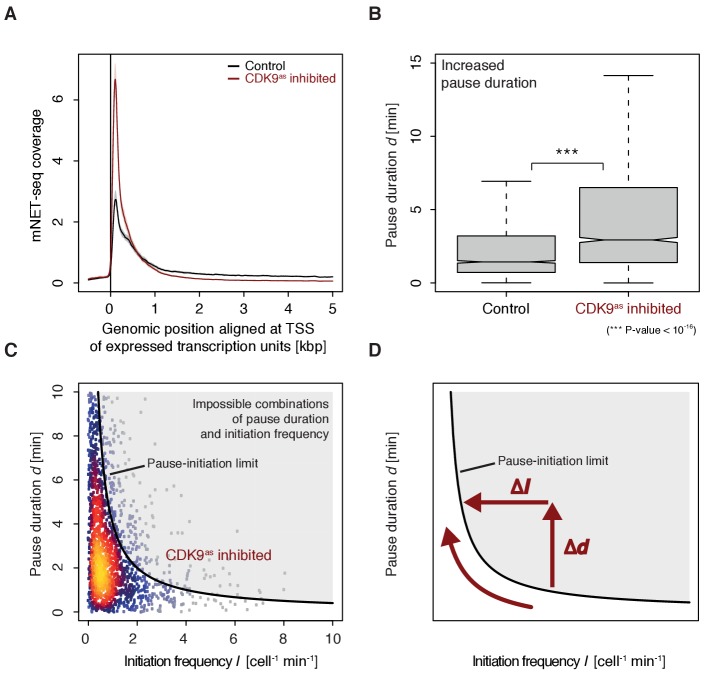
CDK9 inhibition leads to increased pause duration.(A) Metagene analysis comparing the average mNET-seq signal before and after CDK9 inhibition. Two biological replicates were averaged. The mNET-seq coverage was averaged for 2538 investigated TUs (Materials and methods). TUs were aligned with their TSS. Shaded areas around the average signal (solid lines) indicate confidentiality intervals (Materials and methods). (B) Distributions of gene-wise pause duration d [min] before (control) and after CDK9 inhibition. (C) Scatter plot between the initiation frequency I [cell−1min−1] and the pause duration d [min] after CDK9 inhibition for 2135 common TUs with color-coded density estimation. The grey shaded area depicts impossible combinations of I and d (Ehrensberger et al., 2013) assuming that steric hindrance occurs below a distance of 50 [bp] between the active sites of the initiating Pol II and the paused Pol II. (D) Schematic of changes in pause duration (Δd) and initiation frequency (ΔI) upon CDK9 inhibition. As a consequence, data points in panel (D) are moved to the left and upwards.